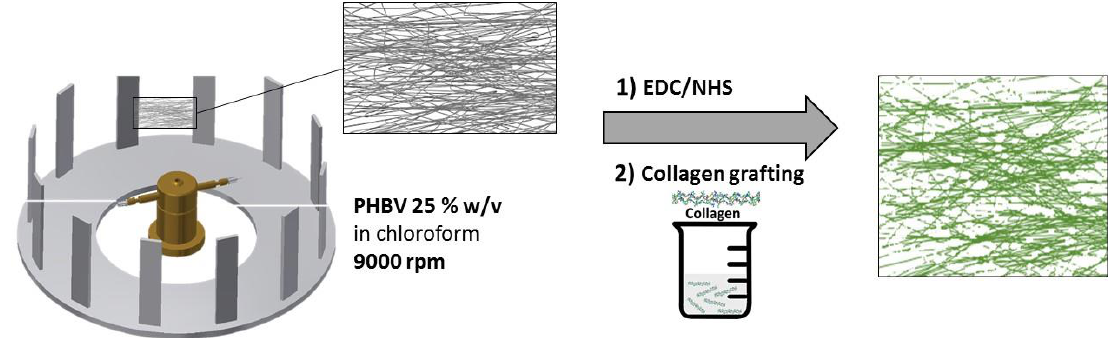
Figure 3. ATR-FTIR analysis of unconjugated (blue) and conjugated (green) fibrous scaffolds Figure 1. Schematic representation of the fabrication process for the PHBV-Collagen enhanced sca ff olds using forcespinning and carbodiimide